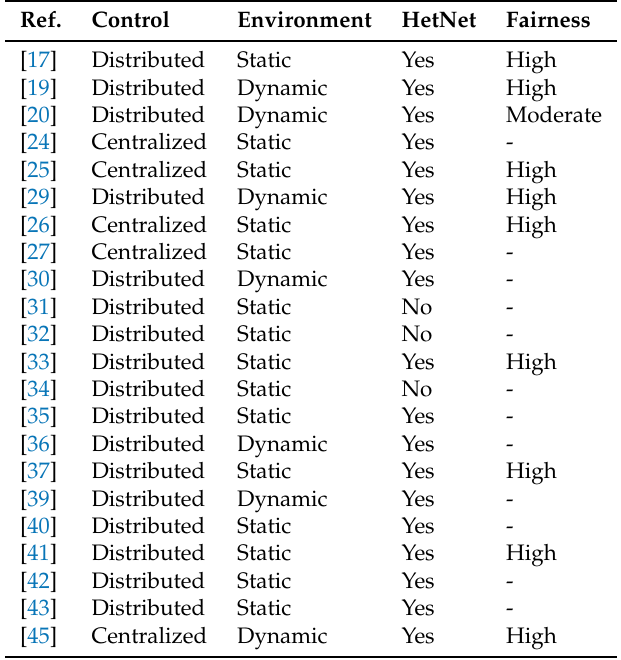
Table 1. Comparison of user association